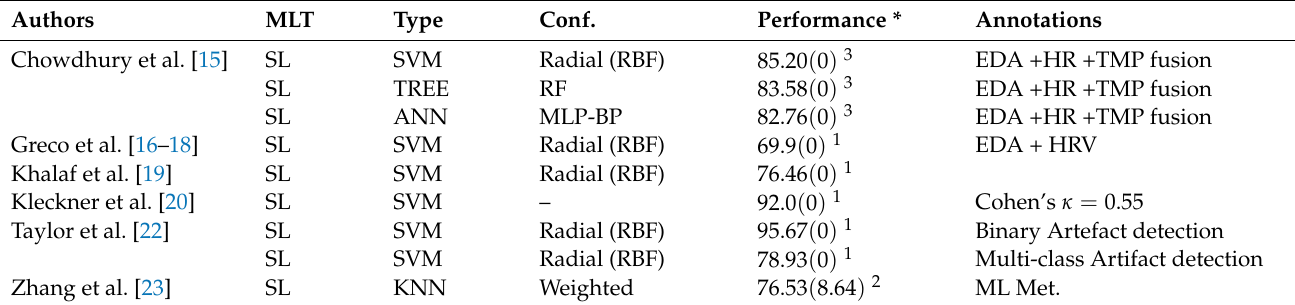
Table 11. Supervised learning methods for arousal classification.